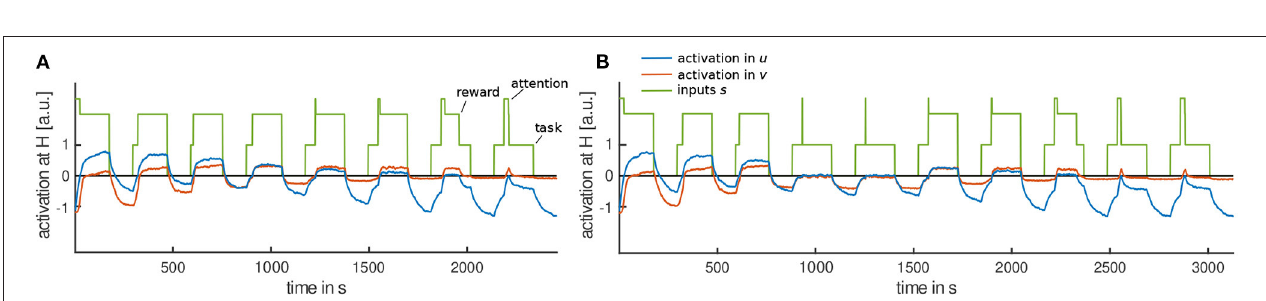
FIGURE 8 | (A) Evolution of movement time over trials for five simulation runs with reward input applied in all trials. The habituation criterion is met at different trials for each run, indicated by the square marker. (B) Evolution of movement time over trials for five simulations for which reward input was omitted on trials 4 and 5, marked by the gray area. The habituation criterion is met at later trials, marked by a square.